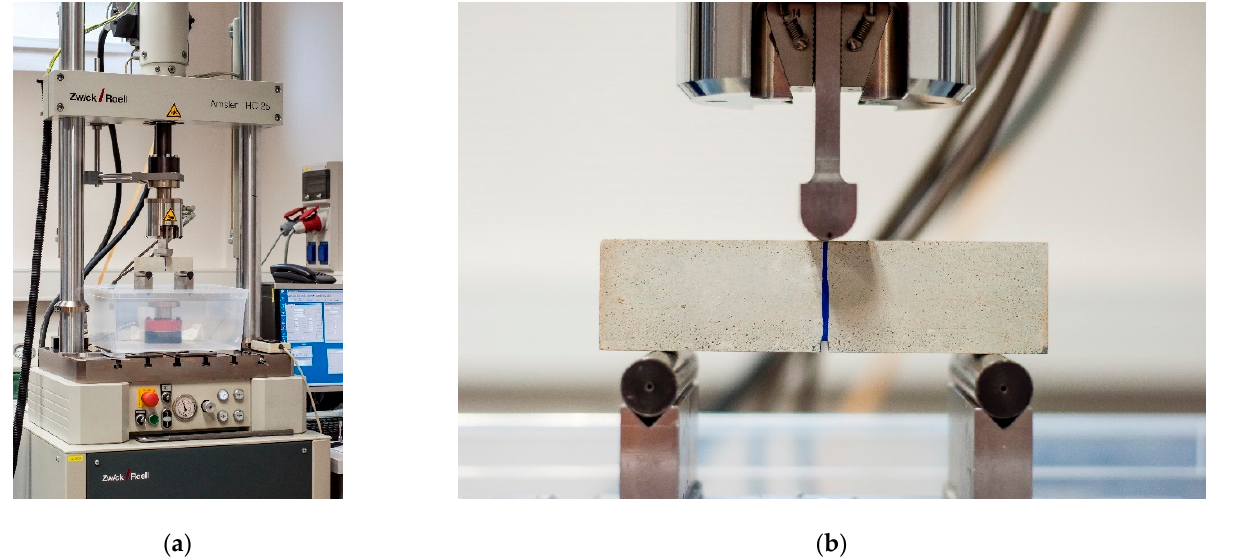
Figure 6. The testing machine used for cyclic/fatigue fracture test ( a ); the arrangement of test ( b ).